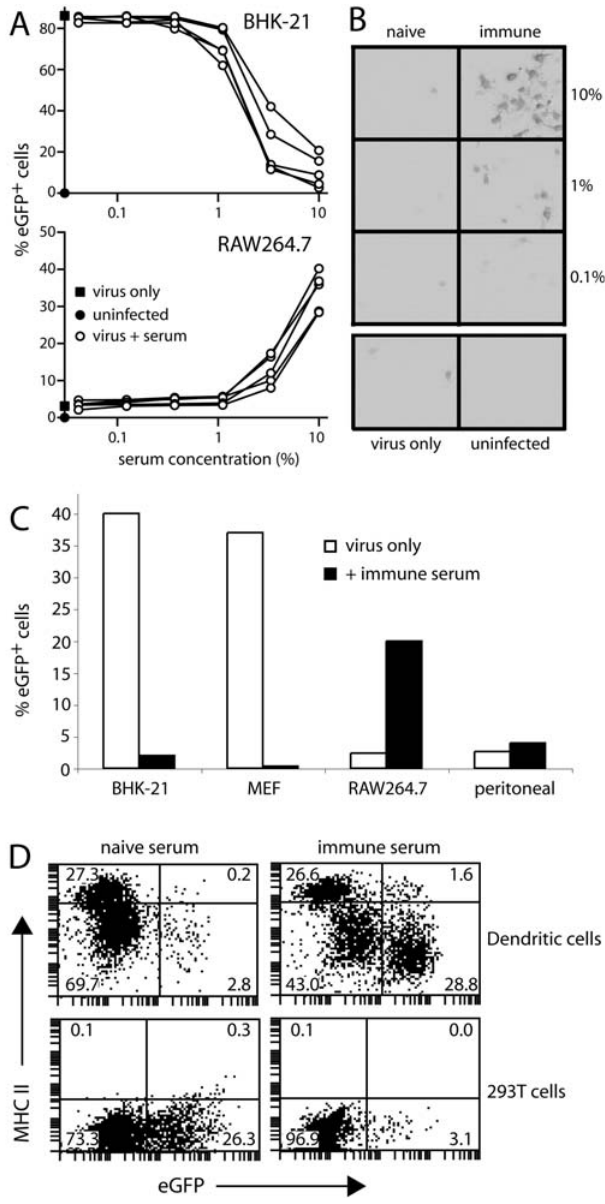
Figure 1. Immune sera enhance MHV-68 infection of Fc receptor + cells. A. BAC + MHV-68 virions (4 6 10 6 PFU/ml) were incubated (1 h, 37 u C) with sera from MHV-68-immune C57BL/6 mice. The serum/ antibody mixtures were then added to BHK-21 fibroblasts (1PFU/cell) or RAW264.7 macrophages (3PFU/cell). 18h later infection was measured by flow cytometry of viral eGFP expression. Each line corresponds to 1 serum sample, pooled from 2 mice. The data are from 1 of 5 equivalent experiments. B. An equivalent experiment using sera from naive or MHV-68-immune BALB/c mice was analyzed by fluoresence microscopy. Each picture shows a 50% confluent culture of RAW264.7 cells. EGFP + cells appear black. C. BAC + MHV-68 virions and immune serum (20 m L/ 3 6 10 5 PFU) were incubated together (1 h, 37 u C) and then divided between BHK-21 cells (0.3PFU/cell), murine embryo fibroblasts (MEF, 0.3PFU/cell), RAW264.7 cells (1PFU/cell) and peritoneal macrophages (1PFU/cell). Viral eGFP expression in each population was determined 18h later by flow cytometry. The data are from 1 of 3 equivalent experiments. CD19 + peritoneal cells were always , 1% eGFP + . D. Bone marrow-derived dendritic cells or 293T epithelial cells were infected with MHV-68 (3PFU/cell) that expressed eGFP-tagged gM and had been pre-treated with 1% MHV-68-immune or naive mouse serum. 21 h later, gM-eGFP expression was quantitated by flow cytometry. Dendritic cells were CD11c + and co-stained for MHC class II as